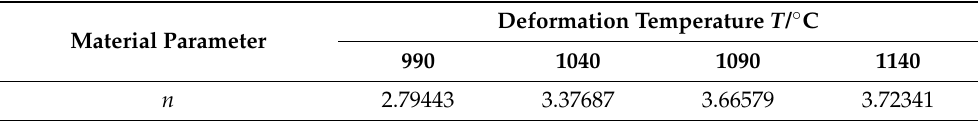
. ε and ε 0.3 under different deformation conditions.